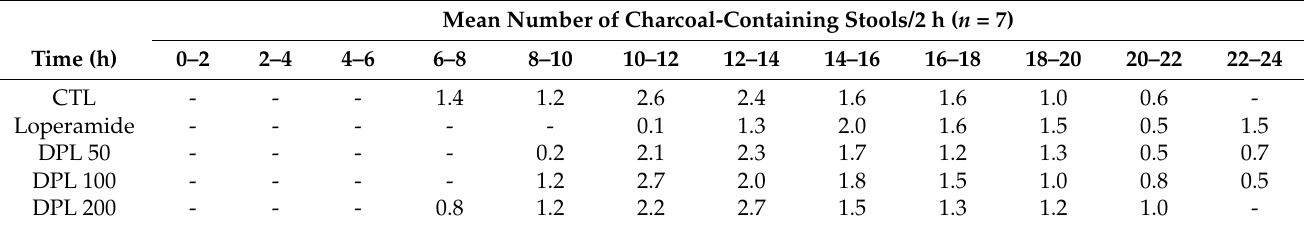
Table 4. The therapeutic effects of D. morbiferus H. Lév. leaf extract (DPL) on gastrointestinal (GI) motility in rats. Mean Number of Charcoal-Containing Stools/2 h ( n = 7)